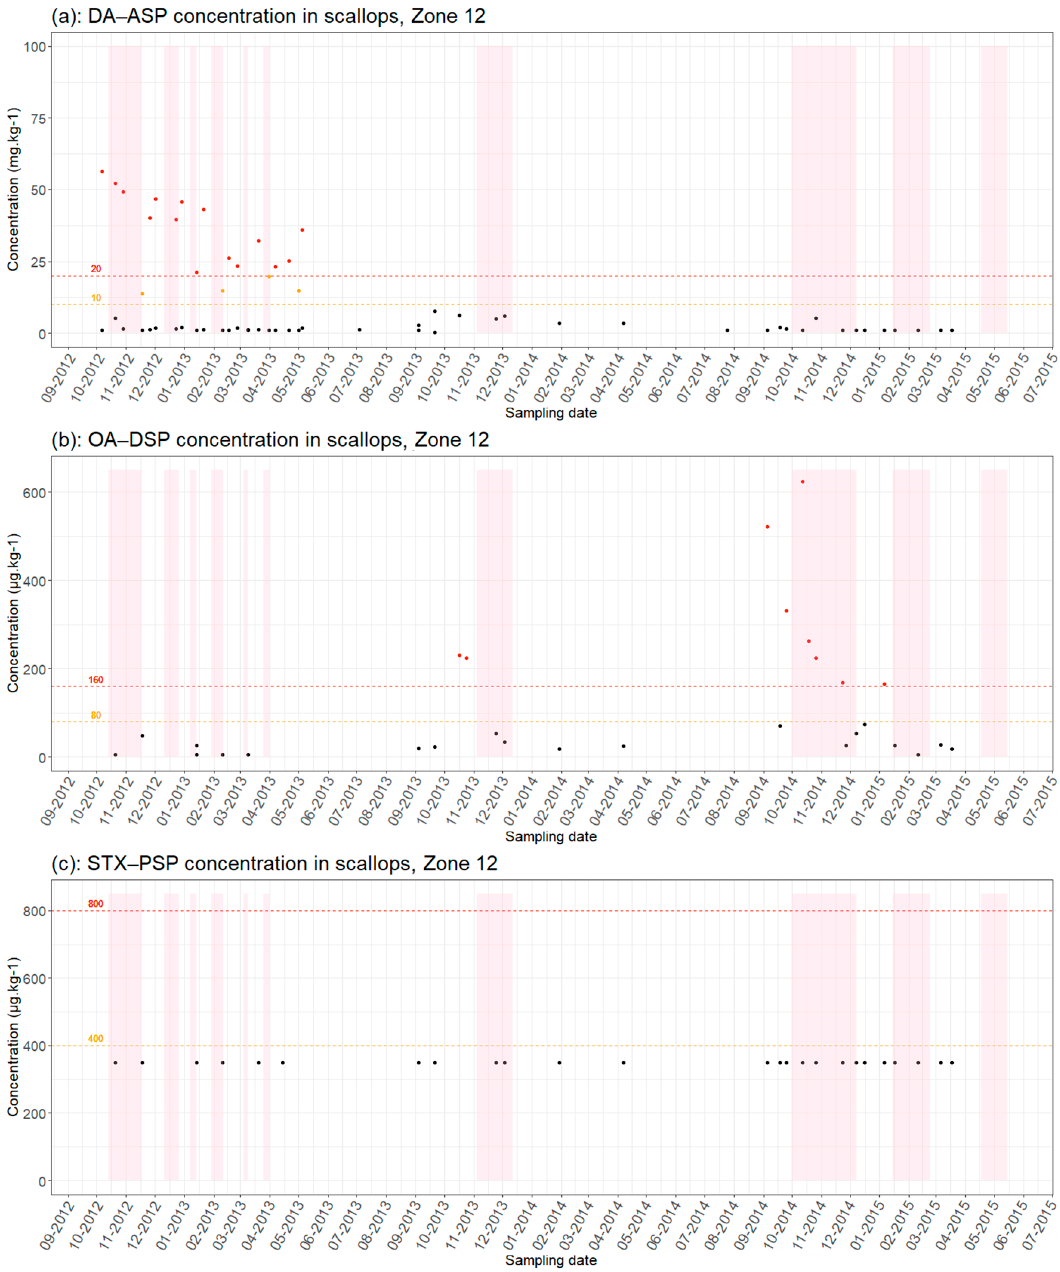
Figure 4. Results of phycotoxin analyses in scallops ( a ) [DA(Domoic Acid) − ASP, ( b ) OA(Okadaic Acid) − DSP and ( c ) SXT (Saxitoxins) − PSP] from production areas 12 from September 2012 to July 2015: Red dots = results > regulatory thresholds; orange dots = results > half regulatory threshold; black dots = results below regulatory threshold; pink background color = closure periods; red dotted line = regulatory toxicity threshold; orange dotted line = half toxicity threshold.